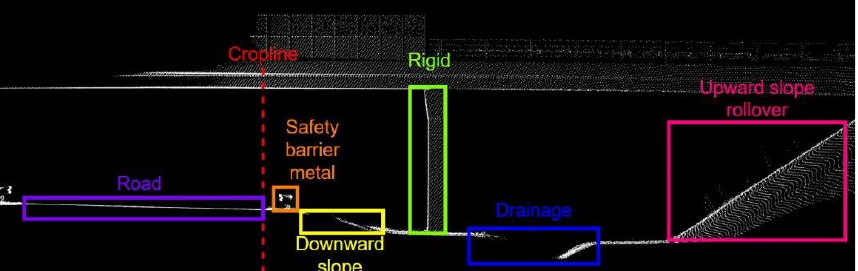
Figure 7. Example of road cross section with labeled iRAP defined objects.